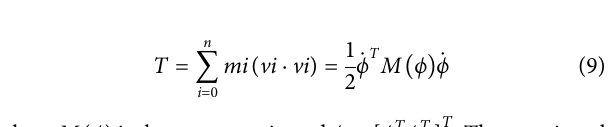
FIGURE 4 | Learned and normalized trajectory distribution for joint